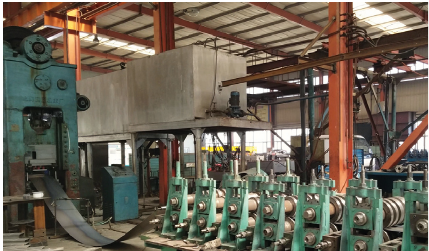
Figure 7: The diagram of roll-forming production line.